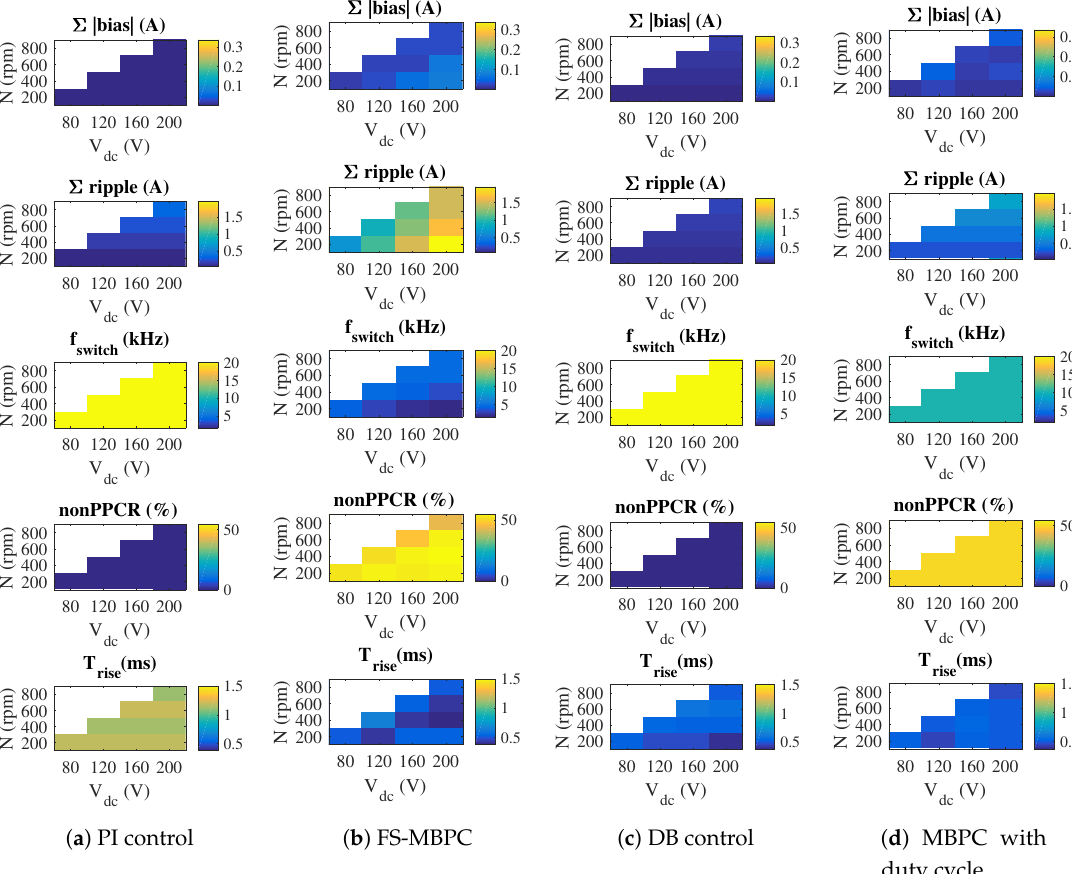
Figure 14. Simulated effect of DC-bus voltage V dc and mechanical speed N on the KPIs with a healthy